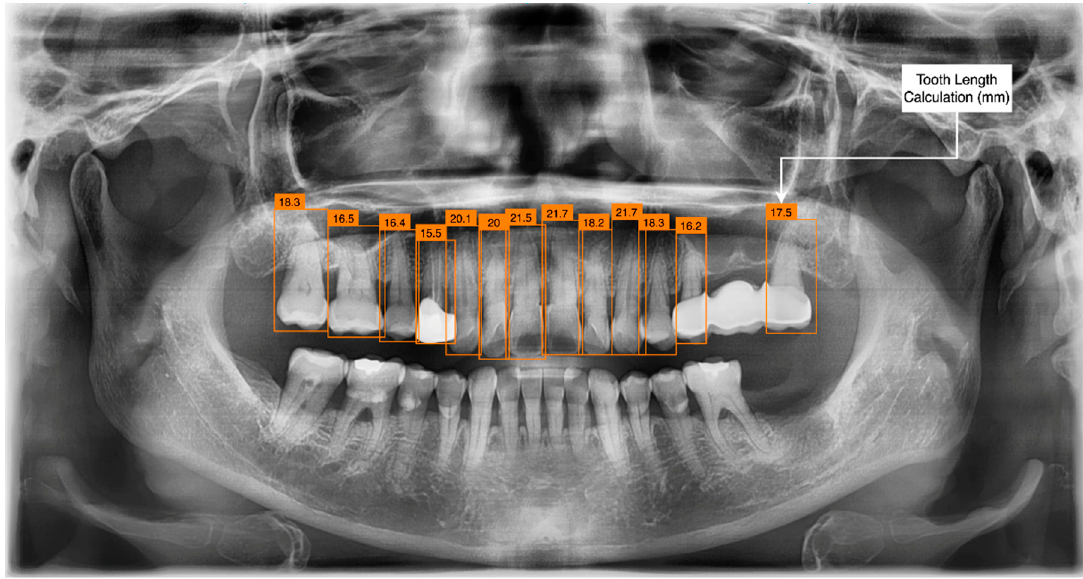
Figure 8. Tooth length detection using a YOLOv5 model.